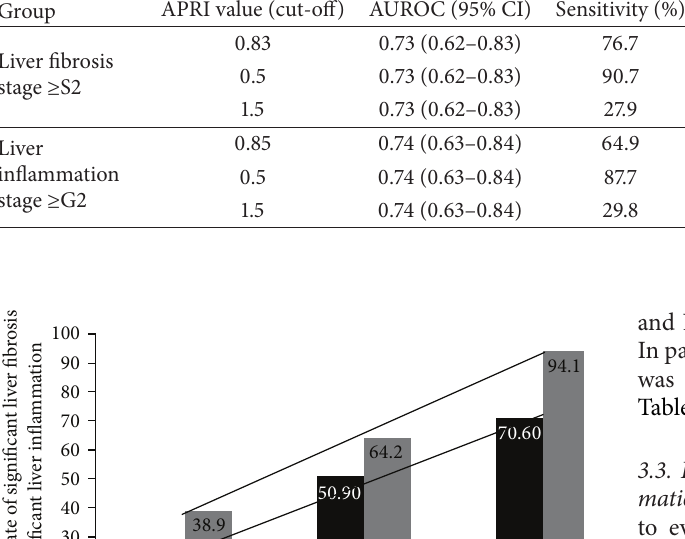
Table 1: The diagnostic value of the APRI for predicting significant liver fibrosis and liver inflammation. Group